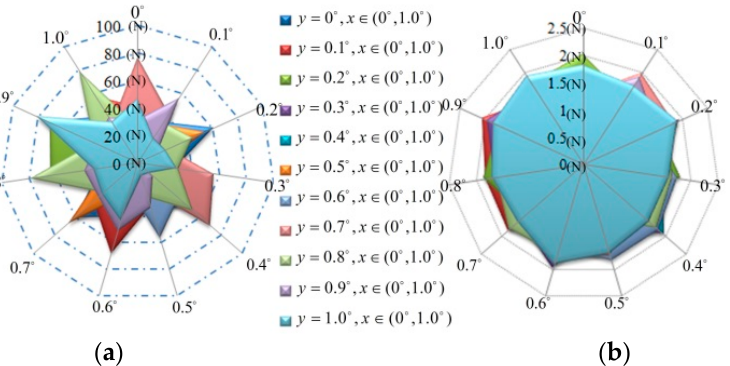
Figure 13. Full stiffness of cylindrical magnetic bearing (suspension forces versus deflection). ( a ) Experimental value. ( b ) Relative error between calculated value and experimental value.